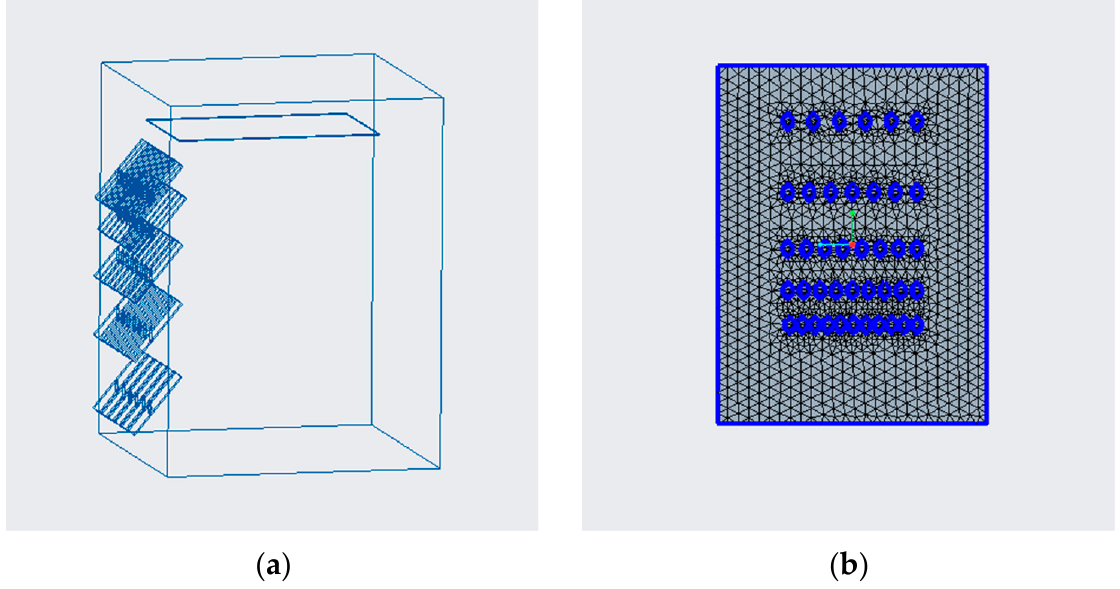
Figure 12. Modeling and meshing of the final solution: ( a ) modeling of the final solution; ( b ) meshing of the final model.